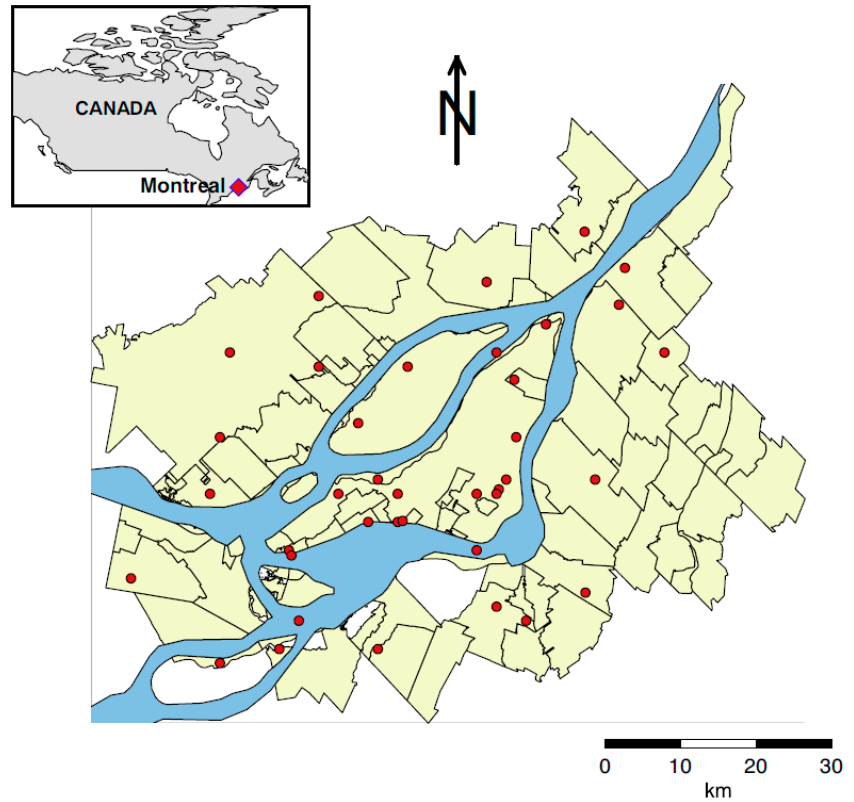
Figure 1. Montreal metropolitan community (Canada). Red dots are the meteorological stations used for measuring meteorological variables.